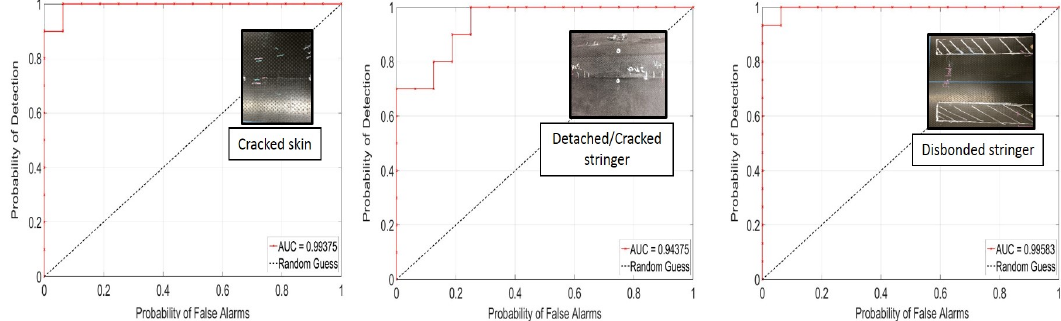
Figure 12. ROC curves for the non-contact NDE technique (skin modes only): cracked skin, detached stringer, and disbonded stringer defects (Panel 3).